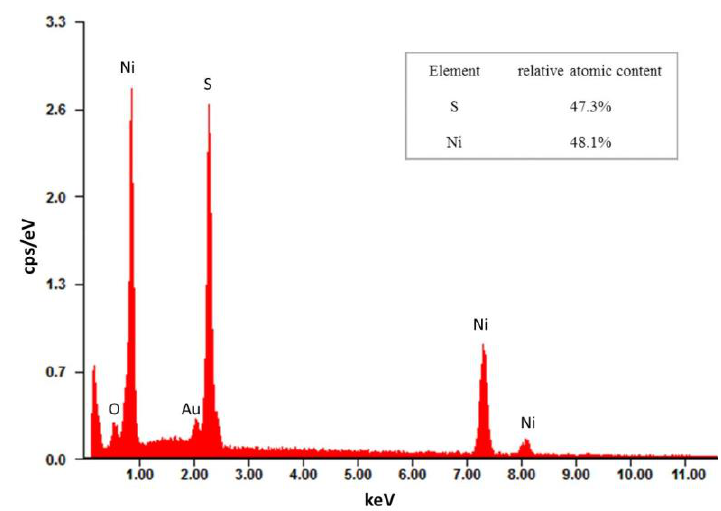
Figure 3. EDS spectrum of nanoporous NiS film.